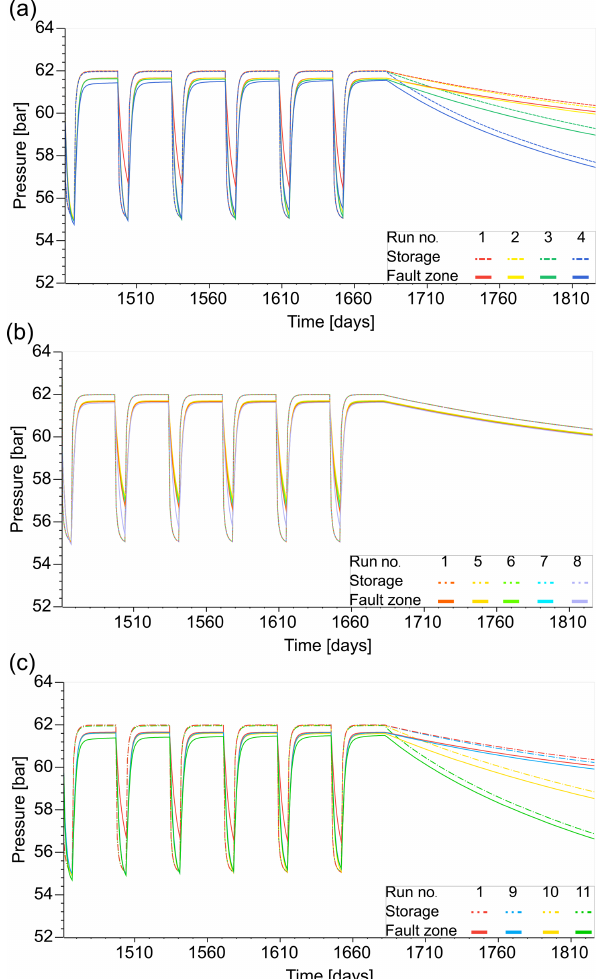
Figure 4. Pressure fluctuation during cycling operation in 2-D model, solid lines represent pressure in the fault zones: (a) sce- nario I – for the damage zone permeability cases; (b) scenario II – for capillary entry pressure cases; (c) scenario III – for normalised capillary entry pressure